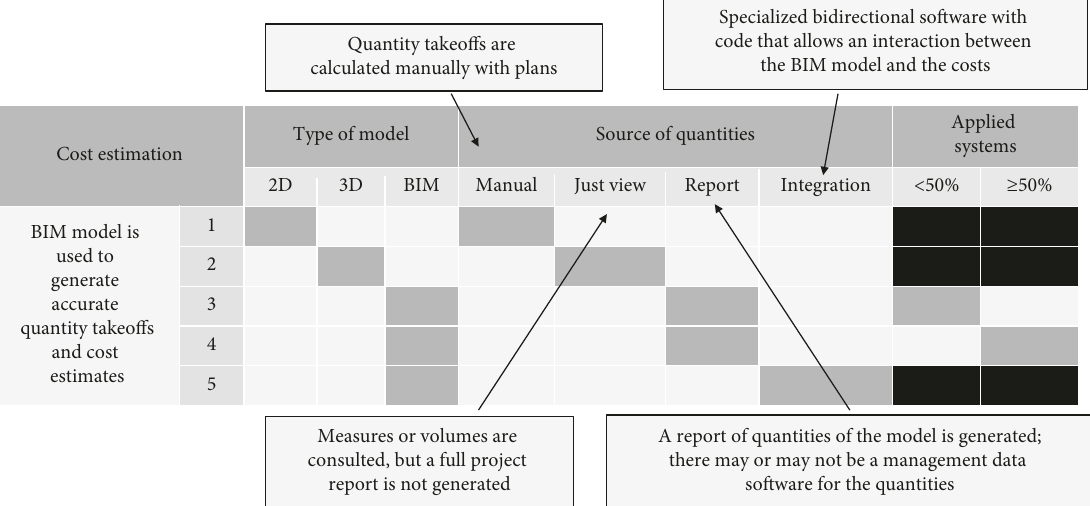
Figure 2: BUA—cost